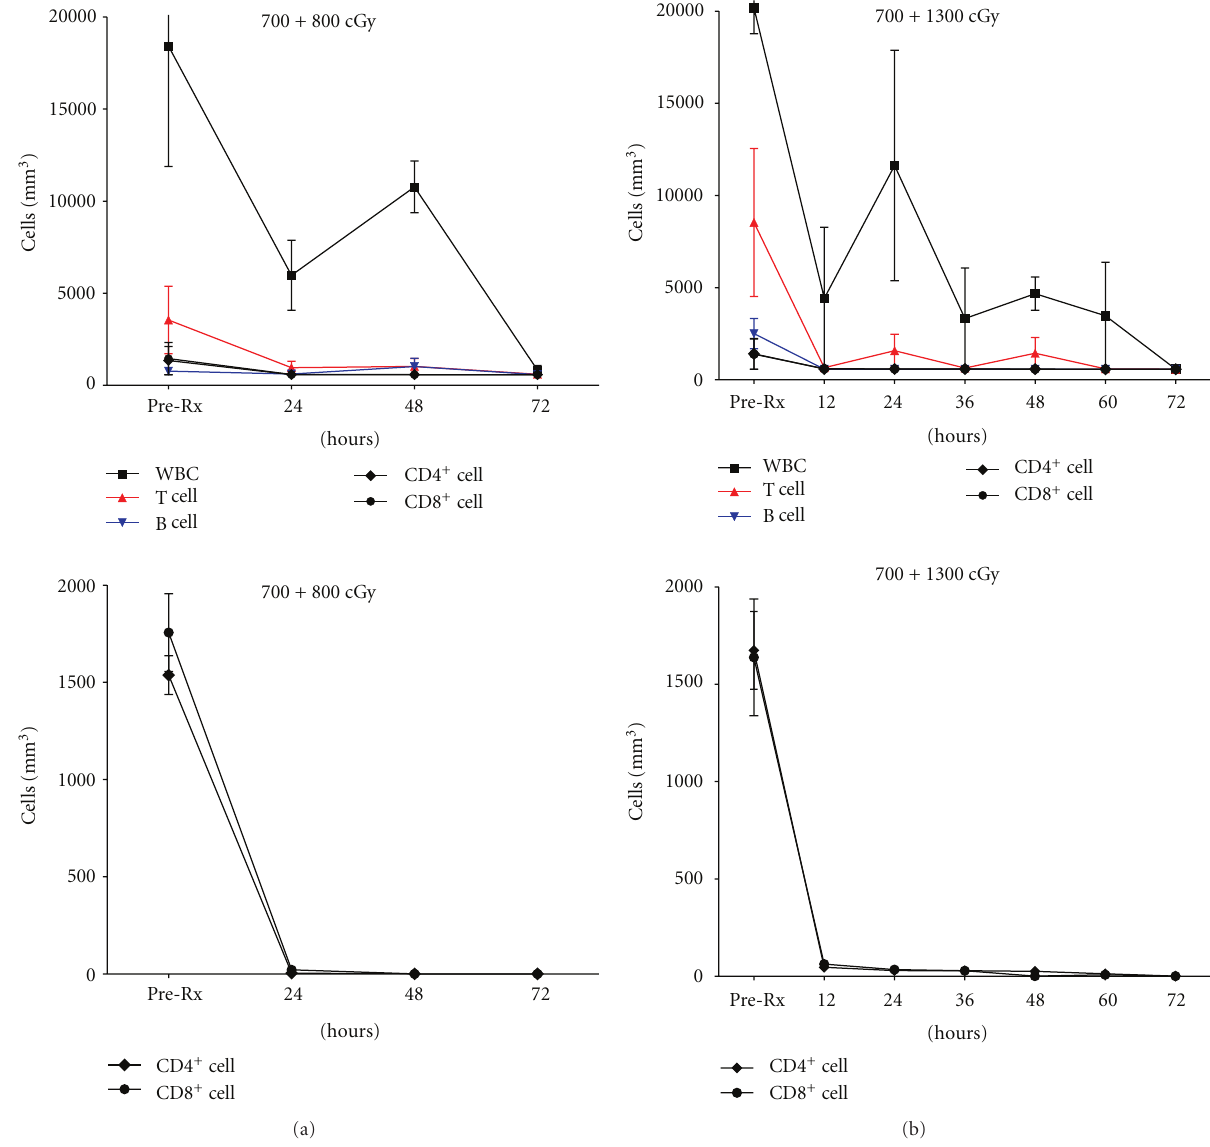
Figure 1: Cell counts in the blood of pigs receiving (a) low-dose or (b) high-dose irradiation. (a) Mean total WBC, T and B cell counts ( left upper ), and CD4 + and CD8 + cell counts ( left lower ) of 3 pigs receiving WBI of 700 cGy and a further 800 cGy with both kidneys shielded. (b) Mean total WBC, T and B cell counts ( right upper ), and CD4 + and CD8 + cell counts ( right lower ) of 3 pigs receiving WBI of 700cGy and a further 1300 cGy with both kidneys shielded. Although T and B cell counts decreased rapidly to < 100cells/mm 3 within 24h after